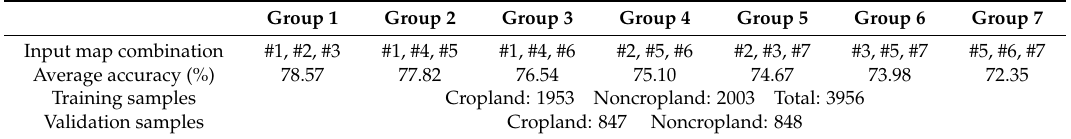
Table 3. The experiment design of the influence of input satellite-based map quality. The cropland maps used are Unified Cropland (#1), GlobeLand30 (#2), NLUD-C (#3), MODIS Collection 5 (#4),